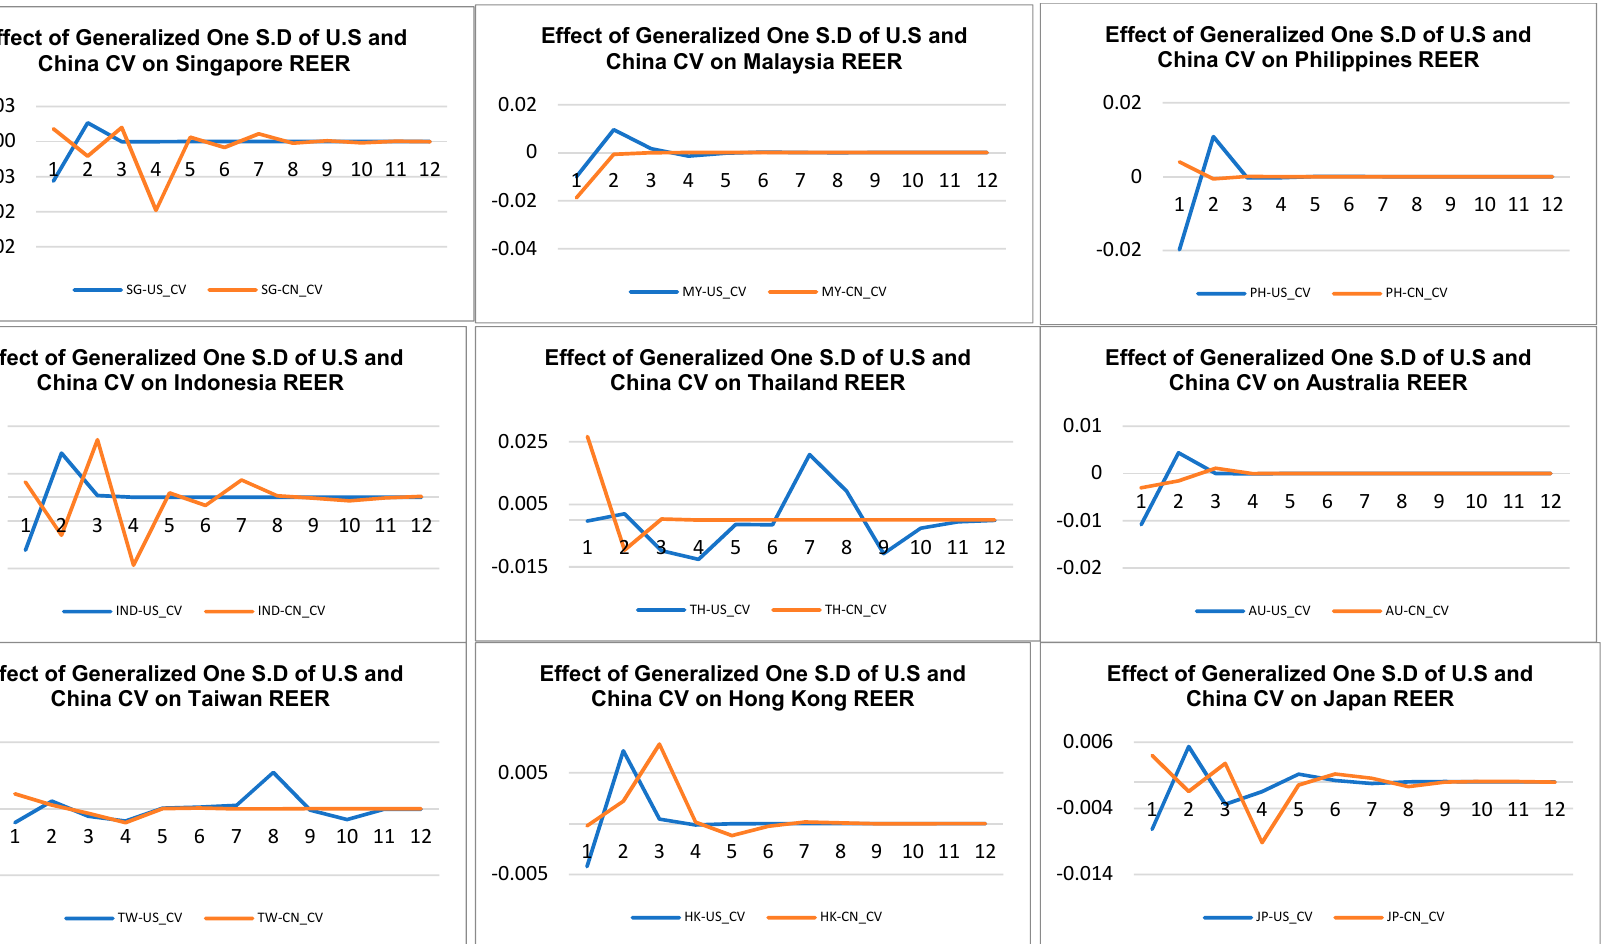
-1.50E-02-1.00E-02-5.00E-030.00E+005.00E-03 Effect of Generalized One S.D of U.S and Figure 6. VAR estimations of the impact of innovations of one standard deviation in the US and China conditional variance (CV) on the APAC REERs.